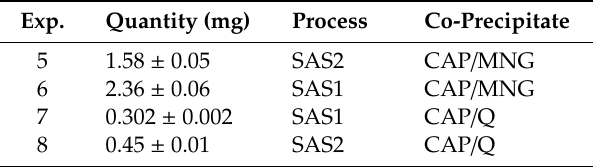
Table 2. Quantity of antioxidant in 5 mg of